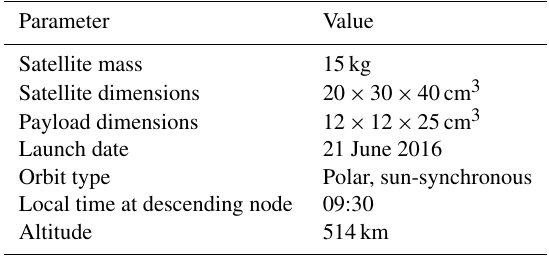
Table 1. Satellite parameters for